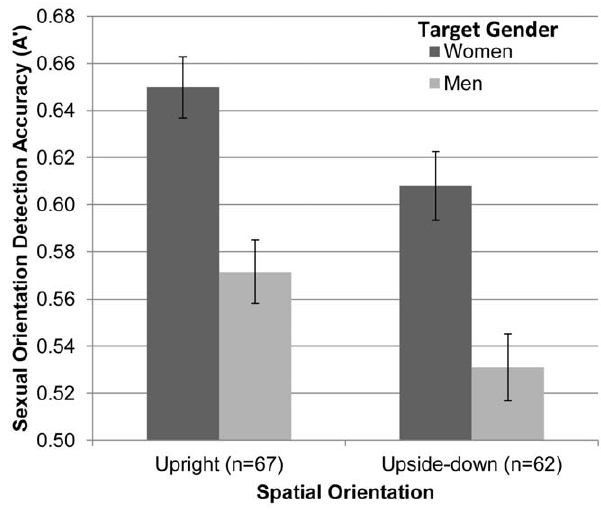
Figure 3. Accuracy of detecting sexual orientation from upright and upside-down faces (Experiment 2). Mean accuracy (A 9 ) in judging sexual orientation from faces presented for 50 milliseconds as a function of the target’s gender and spatial orientation (upright or upside-down; Experiment 2). Judgments of upright faces are based on both configural and featural processing, whereas judgments of upside-down faces are based only on featural face processing. Error bars represent 6 1 SEM